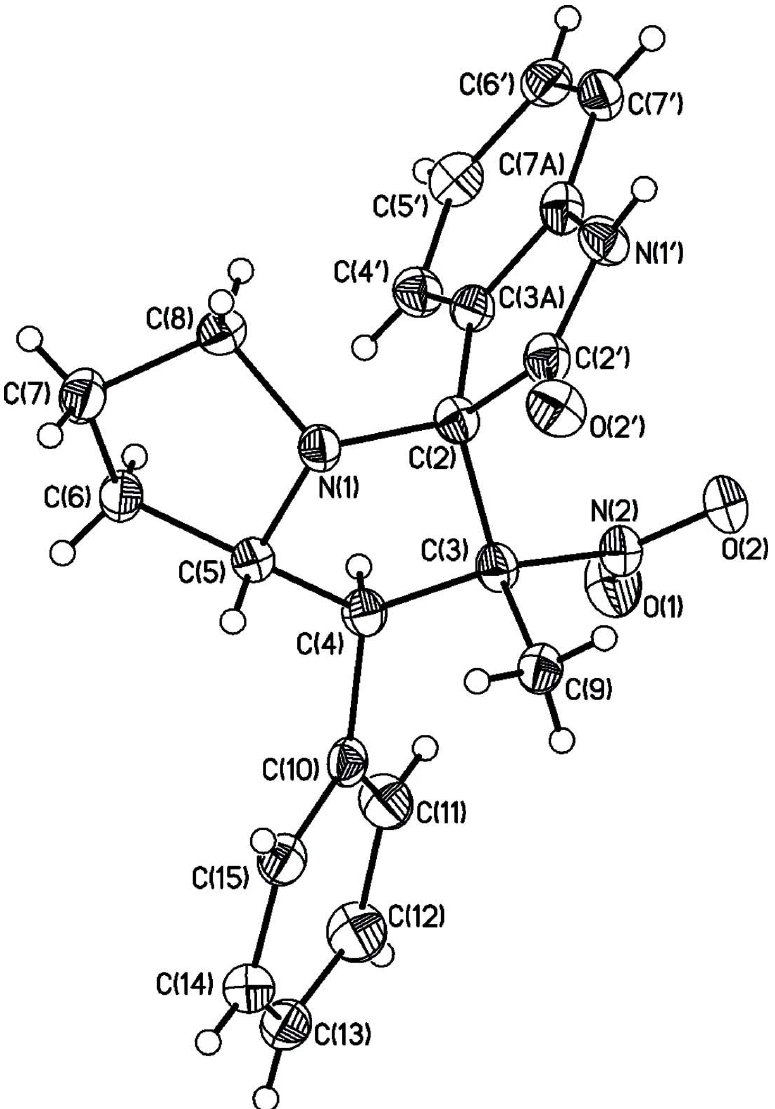
Figure 1 The molecular structure of the title compound with the numbering scheme for the atoms and 50% probability displacement